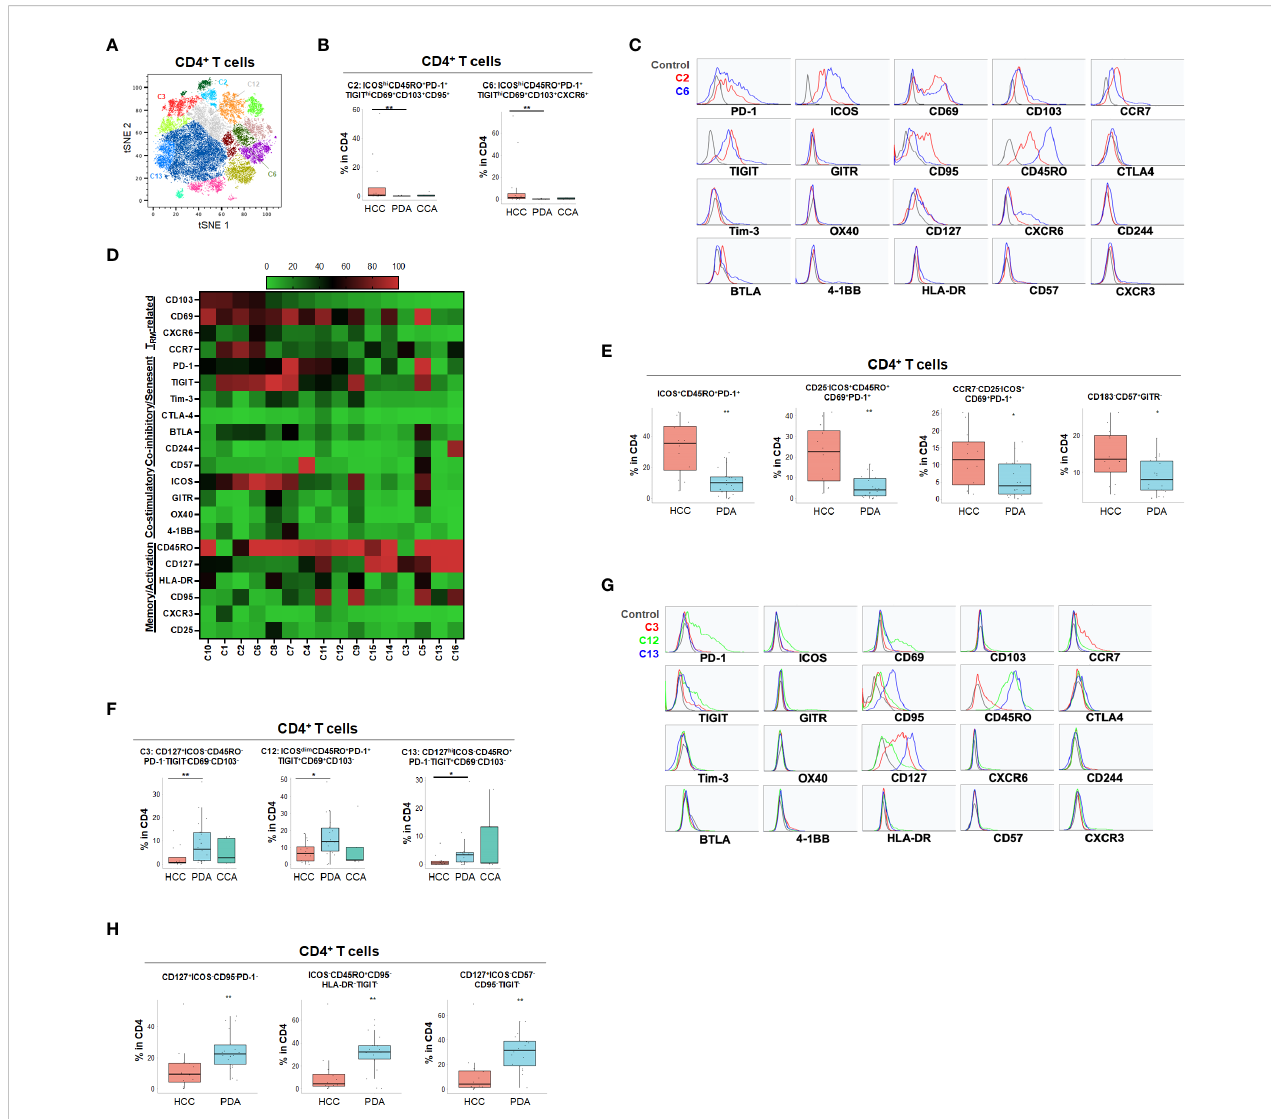
FIGURE 3 Distinct CD4+ T cell phenotypes in liver and pancreatic cancers. (A) tSNE projection of CD4+ T cells showing 16 manual-gated clusters identi fi ed from HCC (n=11), PDA (n=20) and CCA (n=5) patients. Signi fi cantly enriched clusters in HCC (C2, C6) and PDA (C3, C12, C13) are labeled. (B) Boxplots showing percentage of HCC-enriched clusters C2 and C6 in CD4+ T cells from tSNE (A). Box middle lines, median; box limits upper and lower quartiles; box whiskers, 1.5x the interquartile range. **p < 0.01, Kruskal-Wallis test. (C) Histograms show the individual marker expression of CD4+ T cell clusters enriched in HCC, C2 (red) and C6 (blue). (D) Expression of TRM-related markers, co-inhibitory/senescent markers, co-stimulatory markers and memory/ activation markers in 16 clusters of CD4+ T cells is shown in heatmap which is arranged based on the expression level of CD103. (E) Combinatoric frequency analysis of CD4+ marker combinations (TerraFlow-Methods) most frequent in HCC. Boxplots showing representative phenotypes of CD4+ T cells that are signi fi cantly higher in HCC compared to PDA. Box middle lines, median; box limits upper and lower quartiles; box whiskers, 1.5x the interquartile range. *p < 0.05, **p < 0.01, Kruskal-Wallis test. (F) Boxplots showing percentage of PDA-enriched clusters C3, C12 and C13 in CD4+ T cells from tSNE (A). Box middle lines, median; box limits upper and lower quartiles; box whiskers, 1.5x the interquartile range. *p < 0.05,**p < 0.01, Kruskal- Wallis test. (G) Histograms showing the individual marker expression CD4+ T cell clusters enriched in PDA of C3 (red), C12 (green) and C13 (blue). (H) Combinatoric frequency analysis of CD4+ marker combinations (TerraFlow-Methods) most frequent in PDA. Boxplots showing representative phenotypes of CD4+ T cell that are signi fi cantly higher in PDA compared to HCC. Representative statistically and biologically signi fi cant phenotypes are shown. Box middle lines, median; box limits upper and lower quartiles; box whiskers, 1.5x the interquartile range. **p < 0.01, Kruskal-Wallis